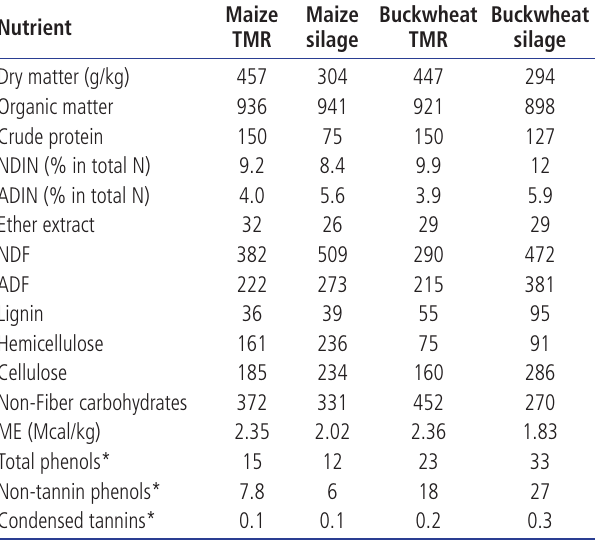
Table 2. Nutritive value of the experimental TMR and silages (g/kg DM,